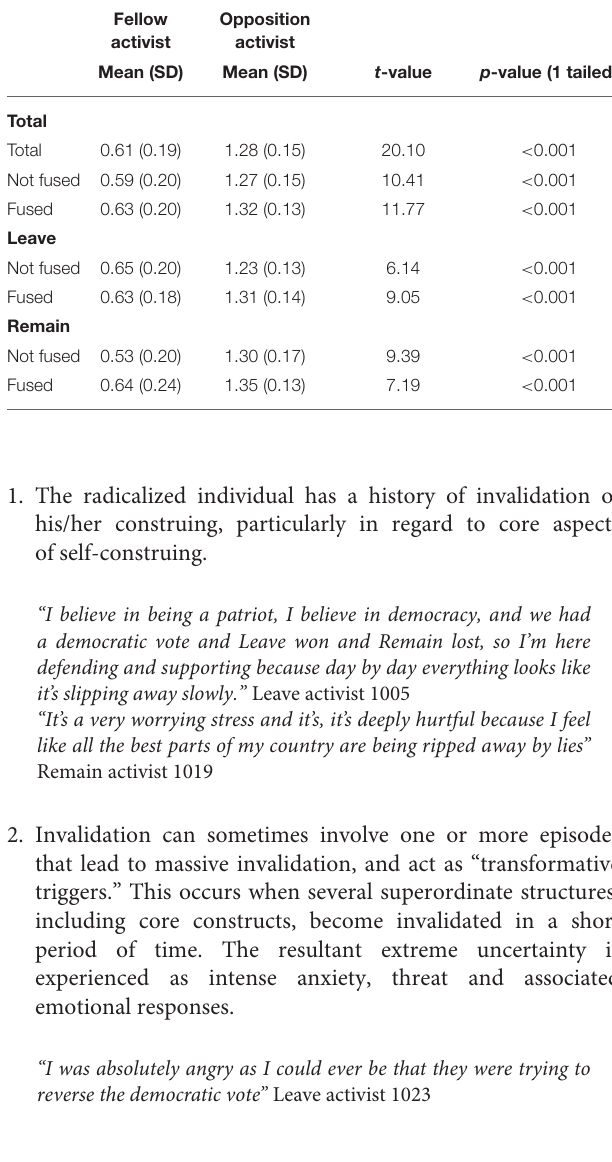
TABLE 2 | Distance from the Ideal Self of fellow and opposition activists by group (larger distances indicate a more negative construing. Group Distance from Ideal Self Significance of difference in distance from Ideal Self